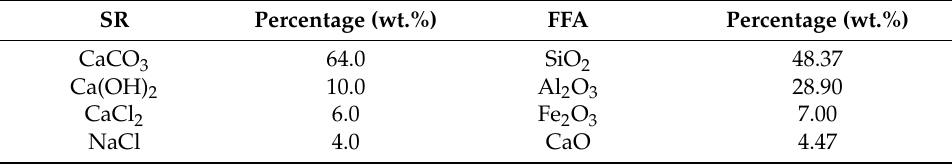
Table 1. Chemical compositions of soda residue (SR) and low-calcium fly ash (FFA) [24]. SR Percentage